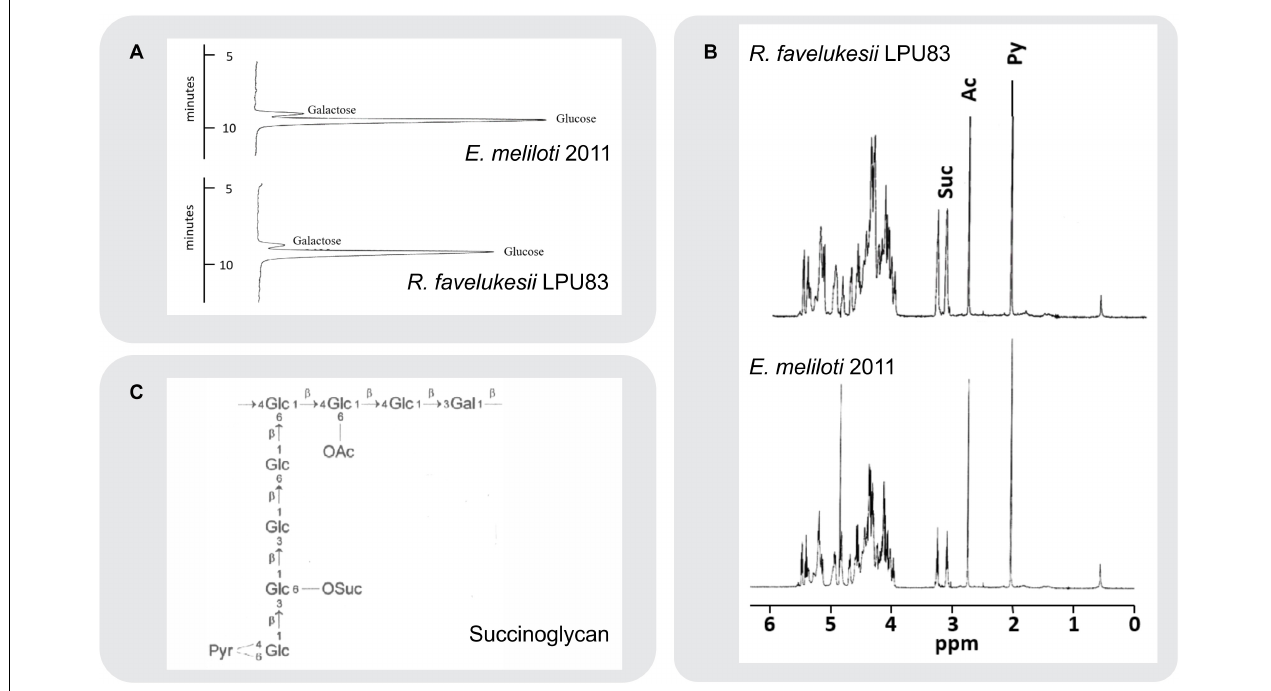
FIGURE 3 | Composition and structural analyses of EPS. (A) Separation of monosaccharides obtained by acid hydrolysis of cetylpyridinium chloride (CPC) and ethanol precipitated culture supernatant of E. meliloti 2011 and R. favelukesii LPU83. The monosaccharides were separated by high-performance anion-exchange chromatography with pulsed amperometric detection on a Carbo Pac PA1 column. Only the relevant parts of the chromatograms are shown. (B) 1 H-NMR spectra of isolated acidic exopolysaccharides (EPS) from R. favelukesii LPU83 and E. meliloti 2011. The singlets at 2.1 and 2.7 ppm represent the methyl protons from pyruvate and acetyl groups, respectively. The triplets at 3.1 and 3.25 ppm arise from the methylene protons of the succinyl group, while the complex region between 3.9 and 5.5 ppm represents signals from the ring protons of the carbohydrate constituents. (C) Structure of E. meliloti EPS I (succinoglycan). Diagram showing the octasaccharide repeating unit of succinoglycan ( OAc , acyl group; Pyr , pyruvyl group; OSuc , succinyl